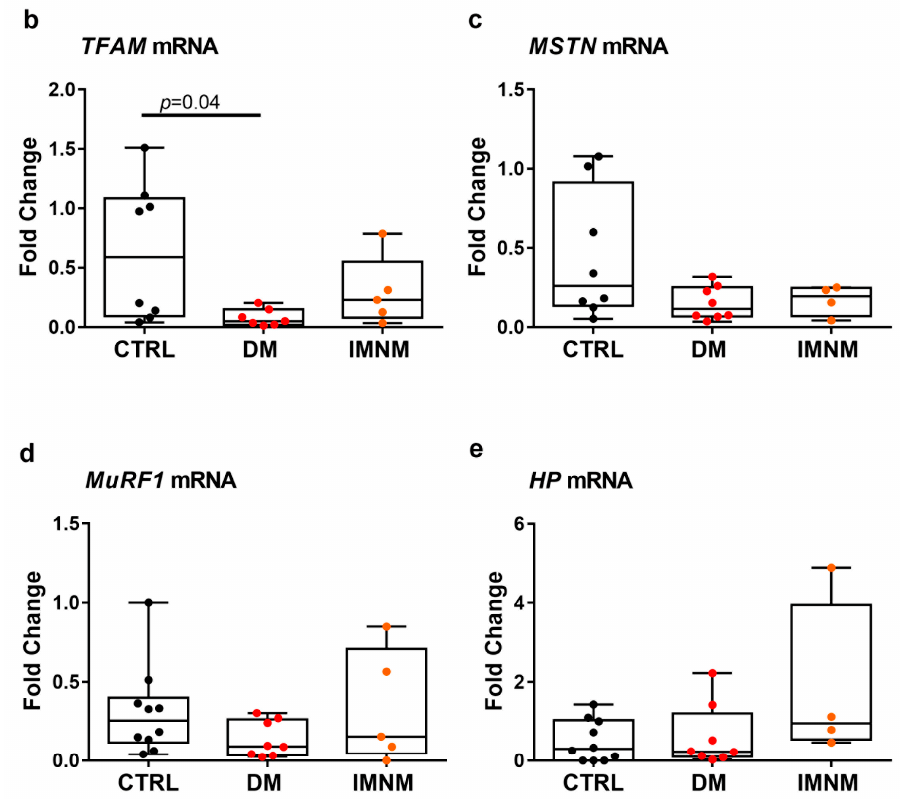
Figure 1. Quantitative PCR (qPCR) showing mRNA expression levels of FNDC5 ( a ), TFAM ( b ), MSTN ( c ), MuRF1 ( d ), and HP ( e ) in muscle biopsies of control subjects (CTRL) and DM and IMNM patients. Gene expression was normalized to the mean of housekeeping genes ( GAPDH and B2M ) and plotted as fold increase from CTRL. D’Agostino and Pearson normality test and Kruskal–Wallis test with two-group comparison by Dunn’s multiple comparisons test were performed. Data are presented as box-and-whisker plot with median and interquartile ranges from max to min with all data points shown; significant results were indicated by p value.